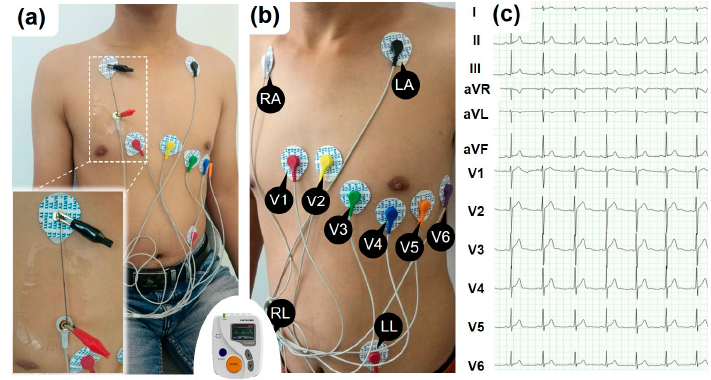
Figure 2. The experimental methods and setup of recording and transmitting human ECG signals using the SWNT-CYs. ( a ) The subject (20 years old, male) is sitting up straight on a chair during the test. Two alligator clips are used to fix the ends of a “wire” made of SWNT-CYs to electrode and the original wire (shown in the inset figure). The CNT-CYs “wire” does not contact the subject’s skin directly during the ECG data collection process; ( b ) the 12-Lead ECG electrodes placement on a volunteer based on the specification of the Dynamic ECG Systems; and ( c ) the ECG signals of these 12 channels measured via the original commercial lead